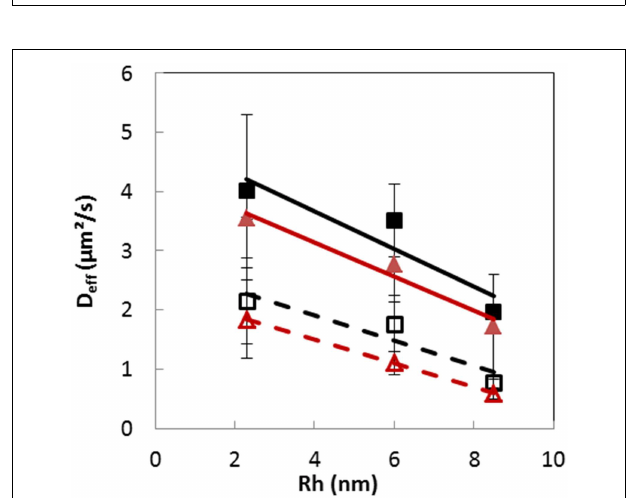
FIGURE 6 | Plots of the mean effective diffusion coefficients (D eff ) of dextrans 10, 70, and 155kDa vs. their respective hydrodynamic radius, estimated from experimental data obtained after 30min, both inside (open symbols) and outside (plain symbols) colonies of Lactoccus lactis LD61 (squares) and TIL1230 (triangles) in a model cheese. Lines, linear regression.